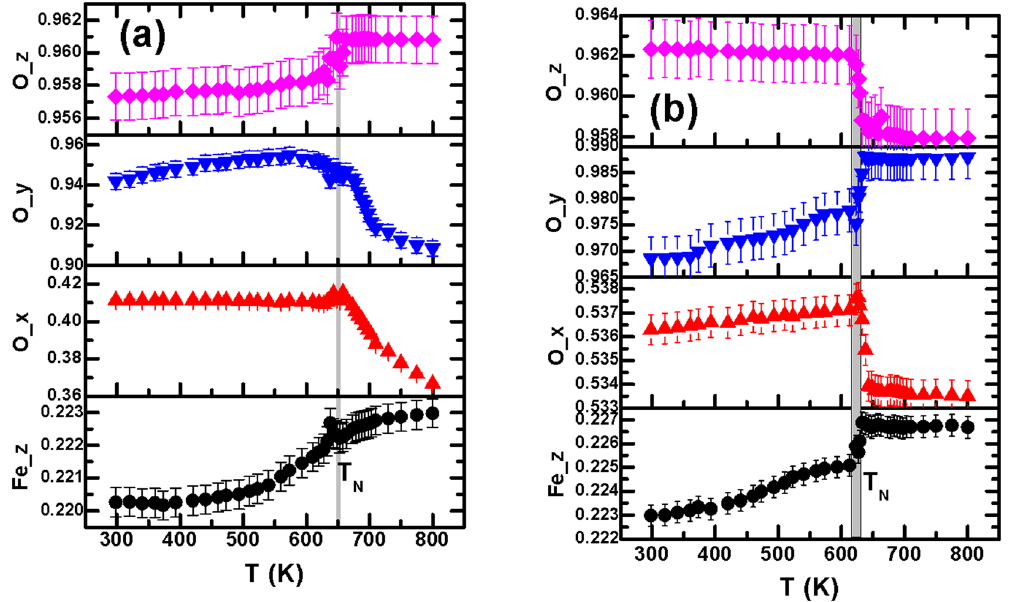
Figure 2. Variation of ion positions with temperature for ( a ) bulk and ( b ) nanoscale ( ∼ 20 nm) BiFeO 3 ; the estimated standard deviation obtained from the refinement was used for drawing the error